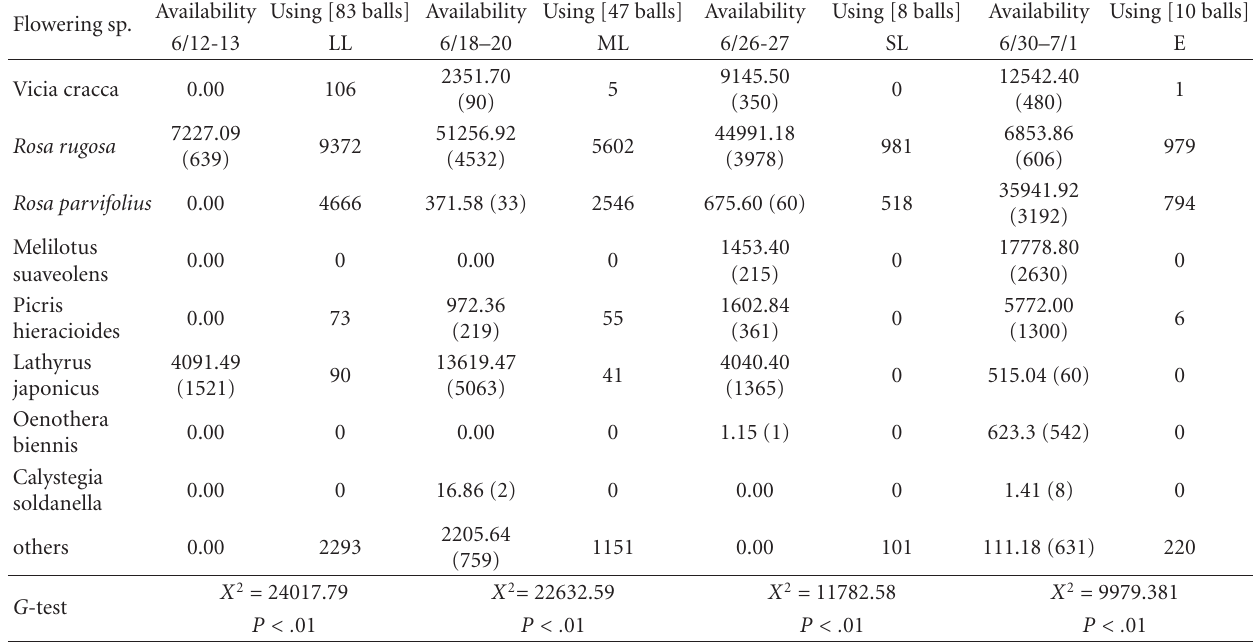
Table 4: Comparison of pollen availability and pollen usage by Ceratina flavipes and Phenology of the total dry weight of pollen for each flowering species during the breeding season of C. flavipes . The number of flowers is shown in parentheses. Total pollen mass was calculated as m × n , where m is the average dry pollen weight per flower (from Table 3) and n is the number of flowers. Availability and usage di ff ered significantly among